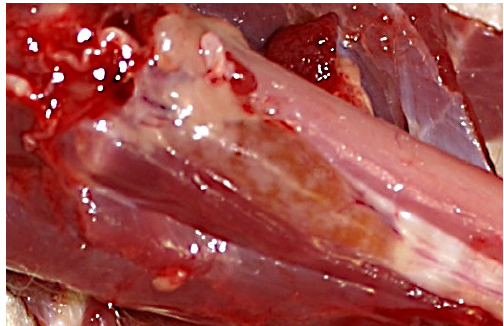
Figure 1. Chronic lymphocytic thyroiditis in a rhesus macaque. The thyroid gland is minimally enlarged, with multifocal to coalescing beige foci.